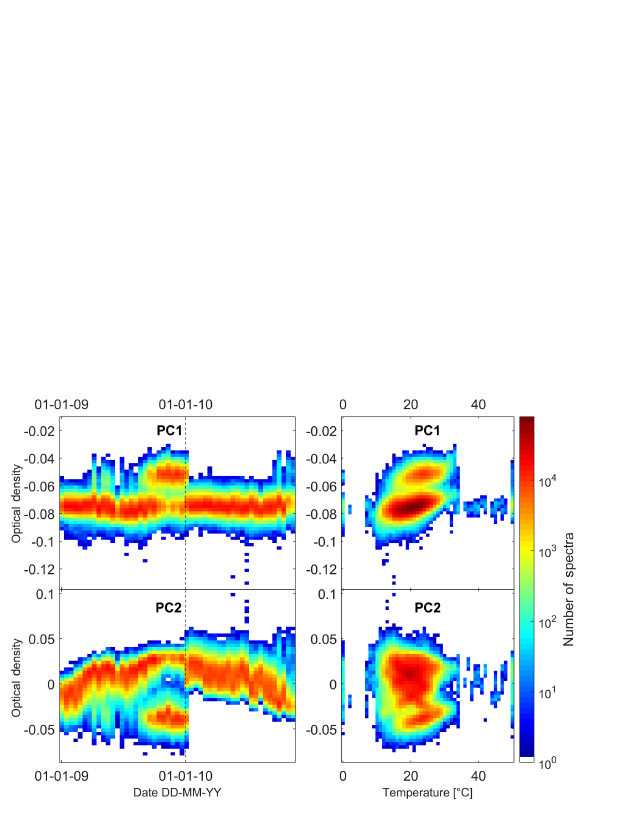
Figure D3. Peak-to-peak apparent optical density (e.g. peak-to-peak optical depth of the principal component times the fit coefficient) of the first and second principal components for instrument I2J8546 at Tungurahua. The two distinct values at the end of 2009 might be due to calibration issues due to a drift of the instrument calibration. Creating the principal components more frequently might help in such cases as can be observed at the beginning of